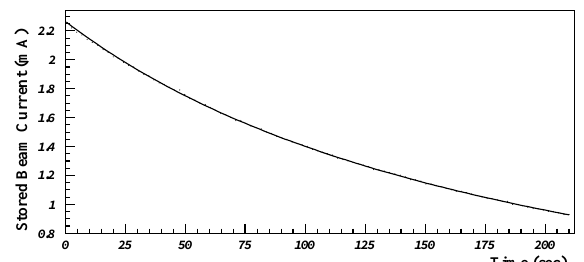
FIG. 2. A typical history of the electron current. The solid line is a fit by a lifetime function to the data. 2 Influence of the electron beam divergence is negligibly small; the beam divergence is expected to be 6 m rad vertically and 40 m rad horizontally at the location of the laser wire, which should be compared with the detector acceptance of 0.2